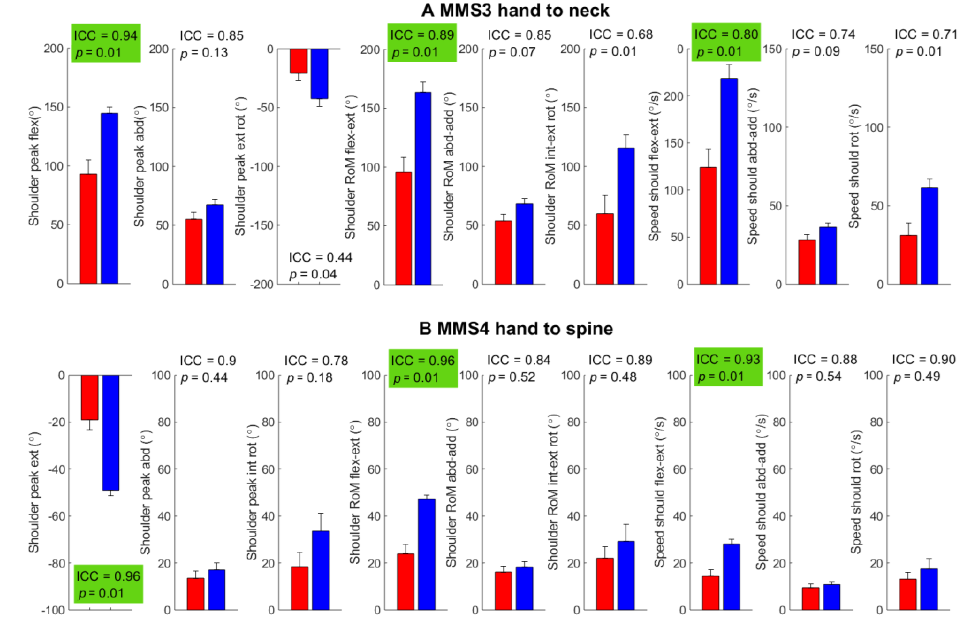
Figure 6. Outcome measures from the assessment of two tasks from the modified Mallet scale (MMS); ( A ) hand to neck and ( B ) hand to spine. Group mean and standard error of mean are illustrated (BPBI: red left bar, control: blue right bar). ICC from test – retest reliability and p -values from t -tests are shown in the upper right corner of each subplot and are highlighted green for outcome scores with both good test – retest reliability (ICC > 0.75) and a significant group difference ( p < 0.05).